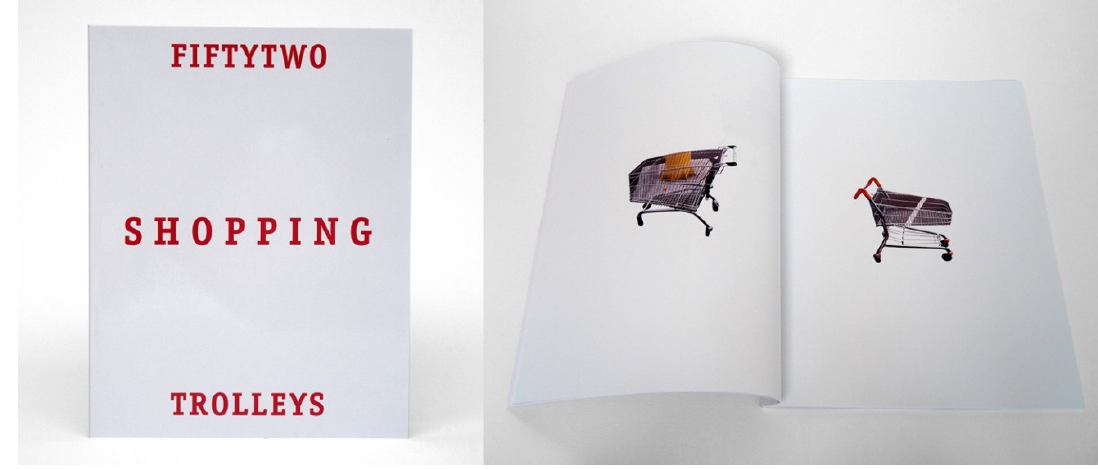
Arts 2019 , 8 , x FOR PEER REVIEW Figure 30. Tom Sowden, Fiftytwo Shopping Trolleys in Parking Lots , 2004. Figure 30. Tom Sowden, Fiftytwo Shopping Trolleys in Parking Lots, 2004.